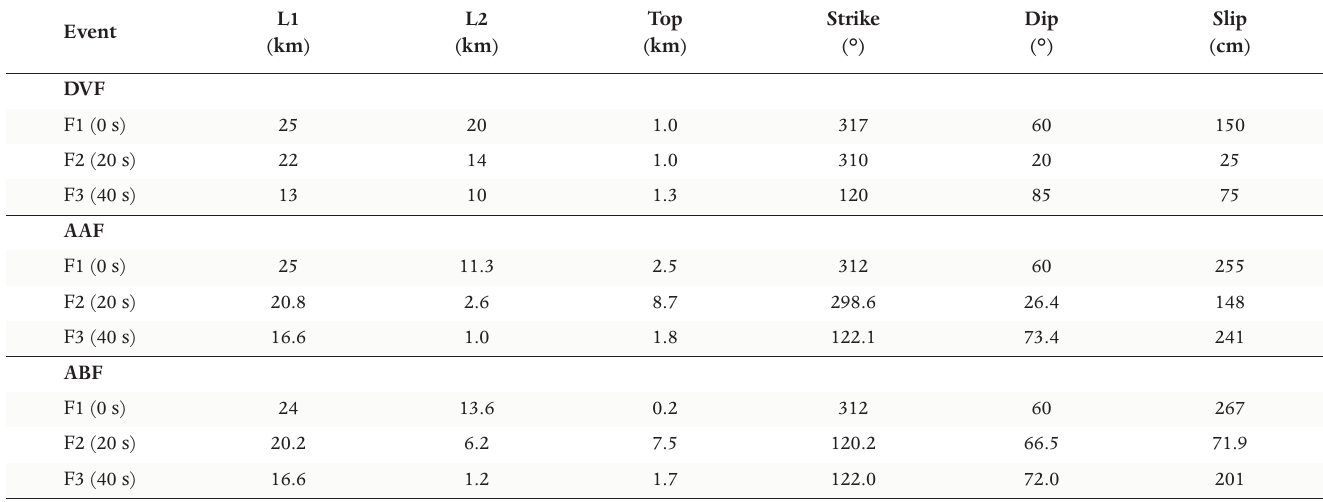
Table 4. Main parameters of the fault systems. DVF , Dalla Via et al. [2003]; AAF , Amoruso et al. [2005a], type A; ABF , Amoruso et al. [2005a], type B. L1, fault length; L2, fault width; Top, depth of fault top